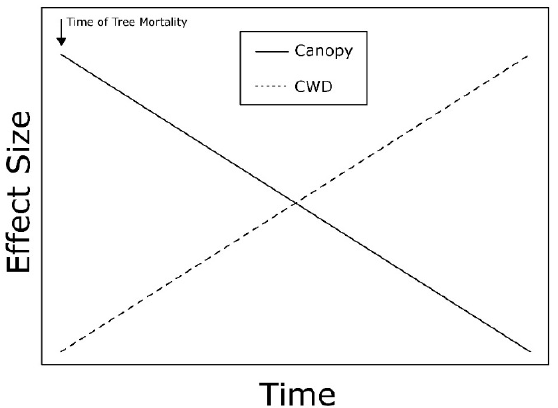
Figure 1. Conceptual model depicting the predicted temporal relationship between the effect sizes of canopy gaps and accumulation of coarse woody debris (CWD) caused by emerald ash borer-induced ash mortality on ground-dwelling invertebrate communities. Time of tree mortality denotes when ash trees die, and not the time of emerald ash borer infestation.